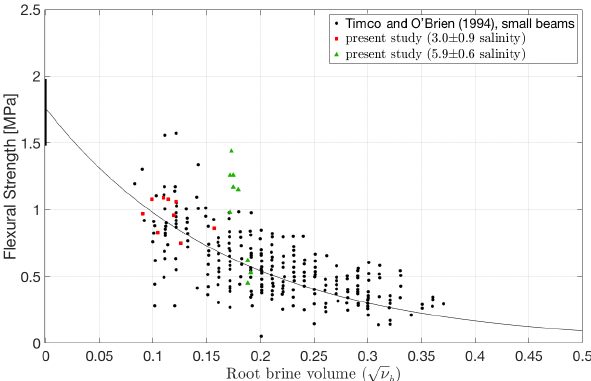
Figure 8. Flexural strength and the corresponding number of cy- cles imposed for saline ice of lower salinity (3.0 ± 0.9)ppt cycled at 0.35MPa outer-fiber stress amplitude at − 10 ◦ C and 0.1mms − 1 outer-fiber center-point displacement